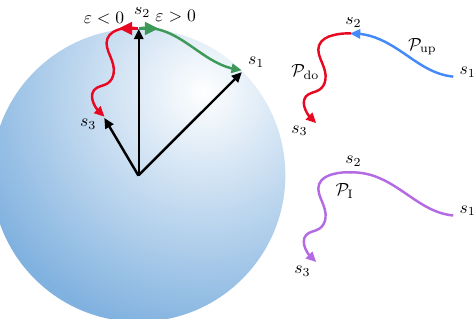
Figure 8: Schematic representation of steps for numerical integration and instanton reconstruction. Kicks with amplitudes of opposite signs allow numerical integration of dynamical paths from the saddle towards the original minimum and from the saddle away from the original minimum. The second path is of the first path is . The dynamical instanton path P up and P do